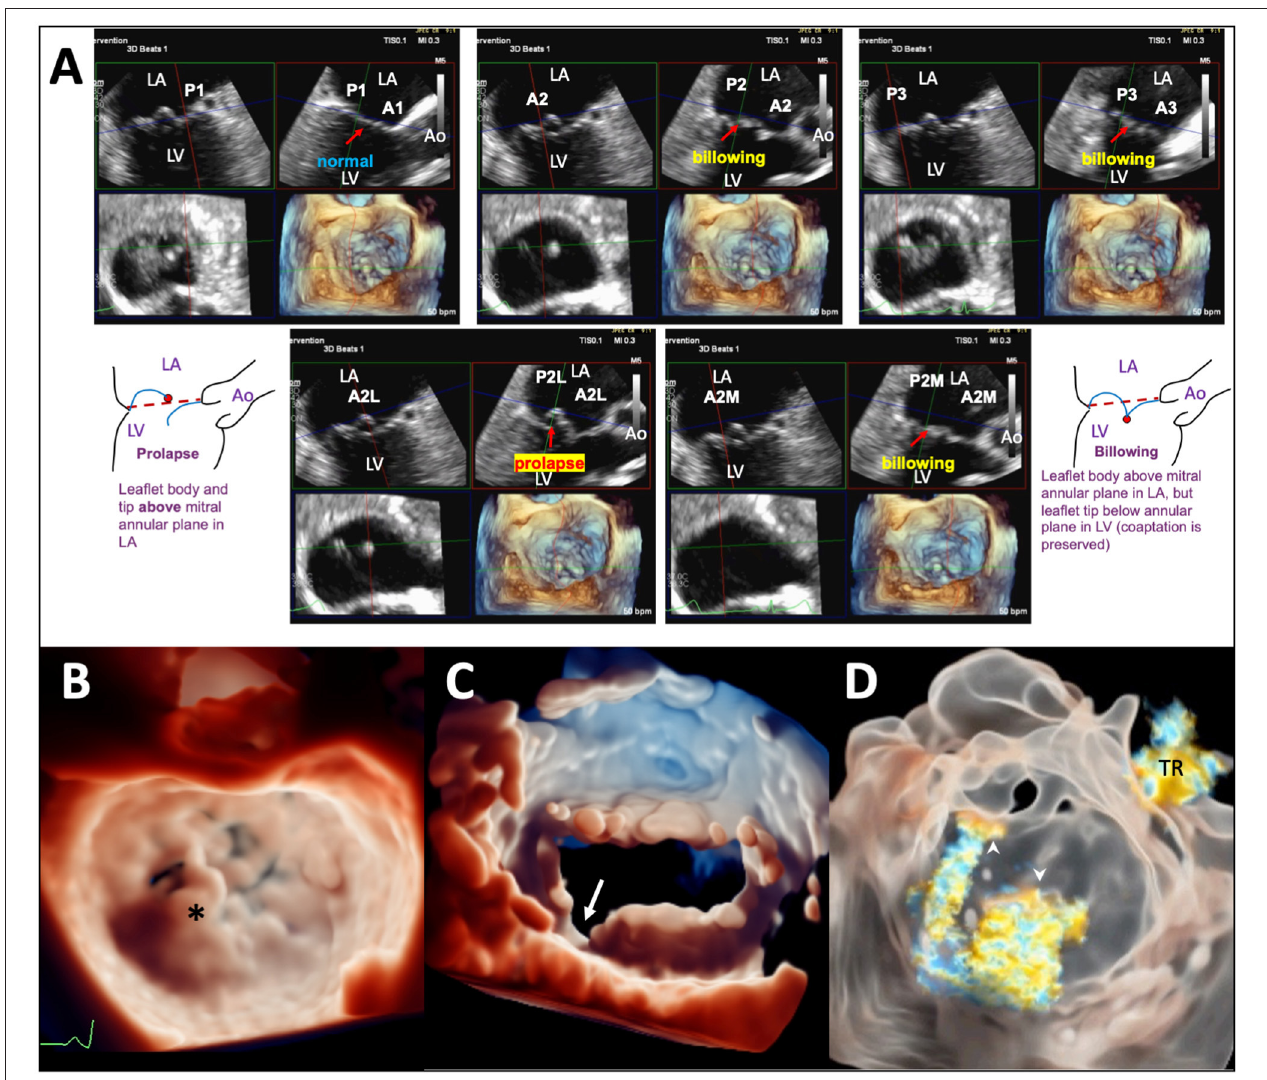
FIGURE 1 | Pre-TEER analysis of MV anatomy and function using advanced TEE imaging techniques. (A) Segmental analysis of leaflet edge anatomy using live 3D MPR on 3D TEE data set of a patients with diffuse myxomatous MV disease. Prolapse is seen in the lateral part of the A2 segment (A2L); other segments show either leaflet billowing or normal leaflet motion. (B) TI in a patient with a flail P2 segment (*). (C) TI of the MV viewed from the LV perspective highlighting a leaflet cleft/deep indentation (arrow) between P2 and P3. (D) TI with transparency rendering in a patient with MR of mixed etiologies showing the origins of 2 separate MR jets (arrowheads), one at A2-P2 (secondary MR component) and another from a perforation of the anterior leaflet near the left trigone (primary MR component). A tricuspid regurgitation (TR) jet is also visualized. Ao, aorta; LA, left atrium; LV, left ventricle; A2L, lateral 1 / 3 of A2; A2M, medial 1 / 3 of A2; P2L, lateral 1 / 3 of P2; P2M, medial 1 / 3 of